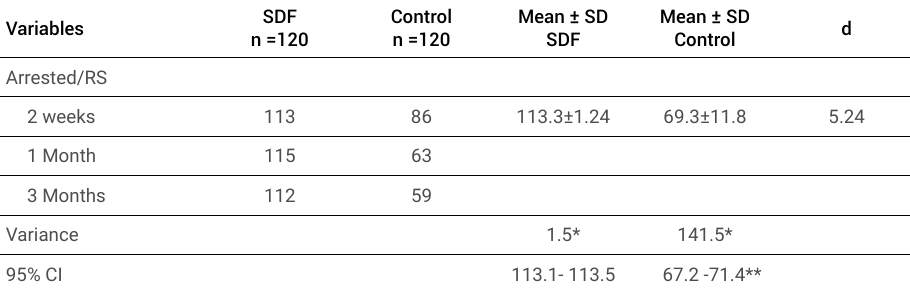
Table 4. Mean outcome of the two groups at different intervals of assessment and the effect size